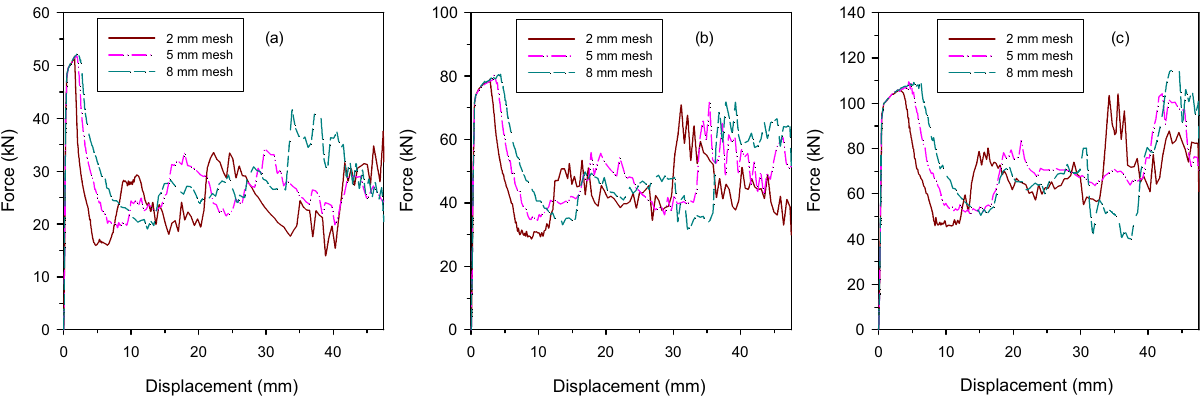
Figure 21: Force versus displacement curve with di ff erent mesh sizes and three di ff erent wall thicknesses. ( a ) 2 mm, ( b ) 3 mm, and ( c ) 4 mm.